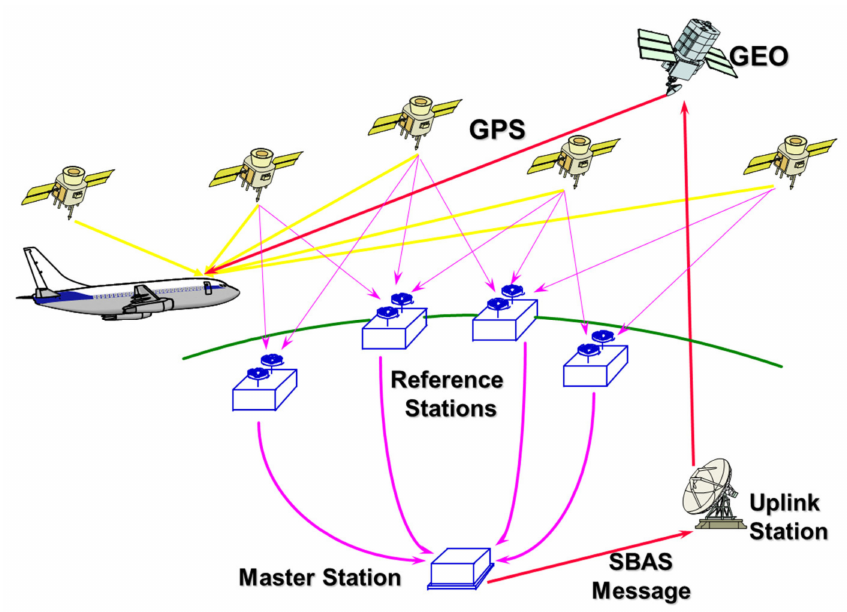
Figure 1. Satellite-Based Augmentation System (SBAS) architecture [14].